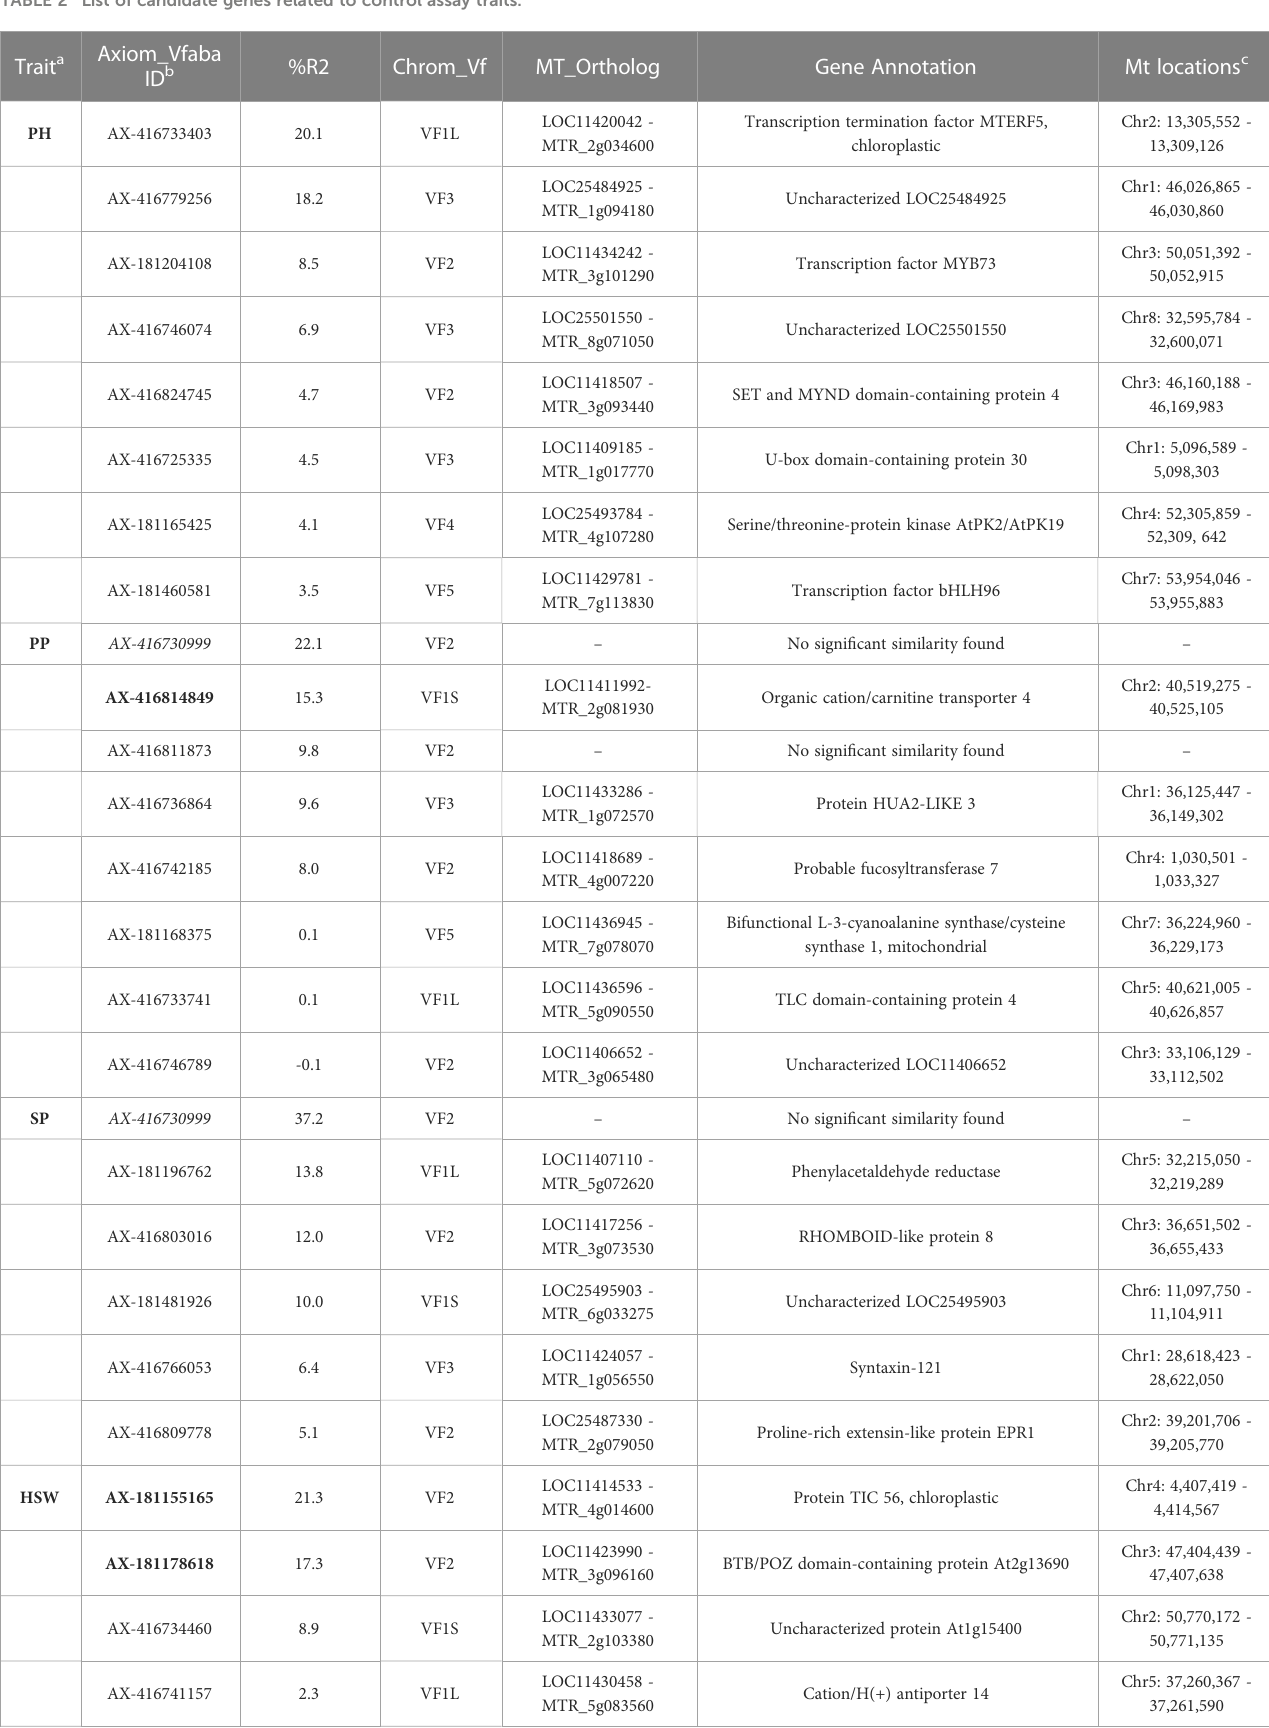
TABLE 2 List of candidate genes related to control assay traits.